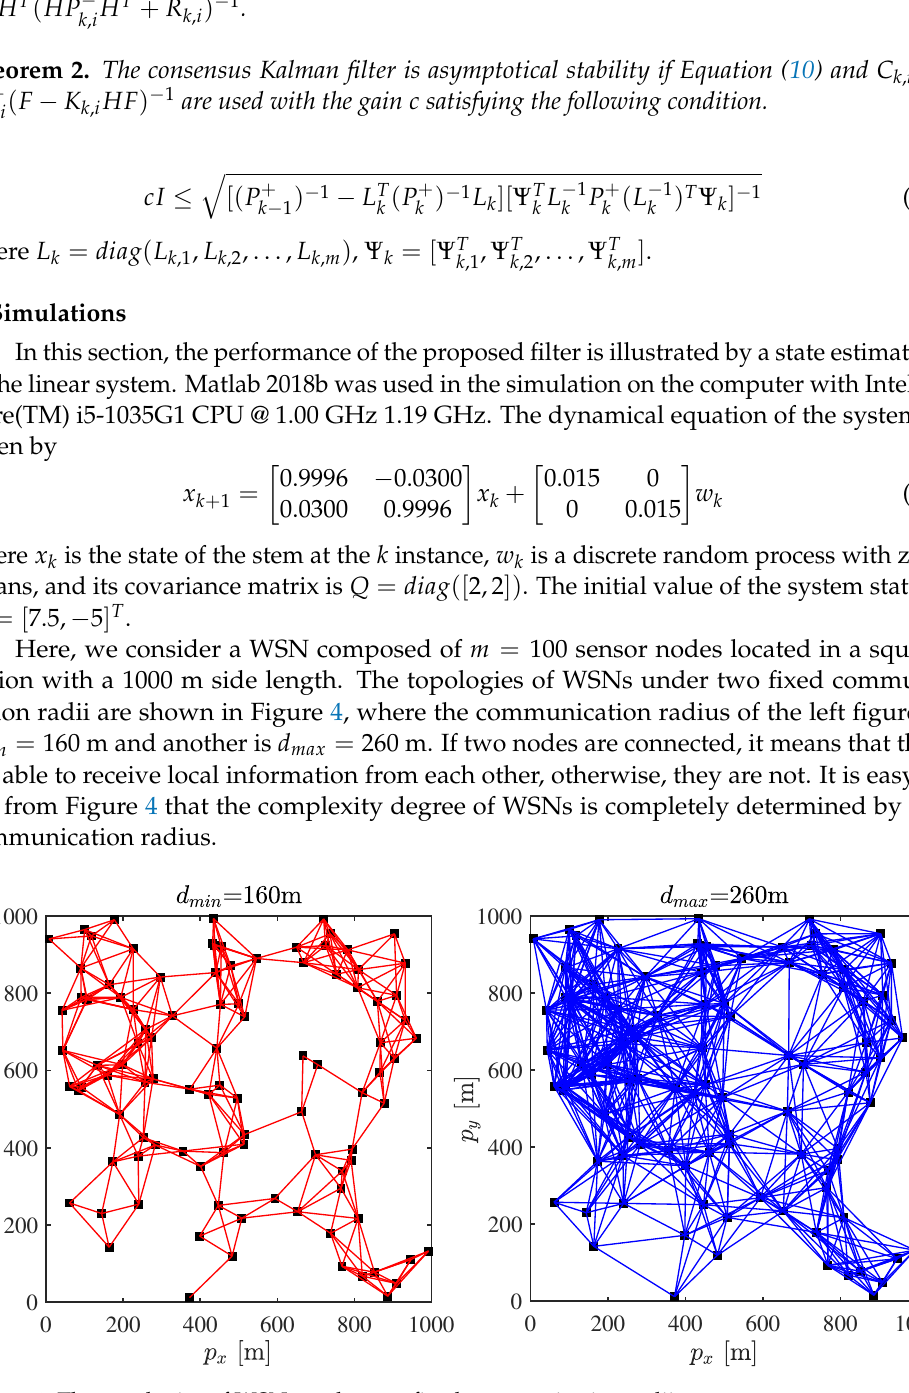
Figure 4. The topologies of WSNs under two fixed communication